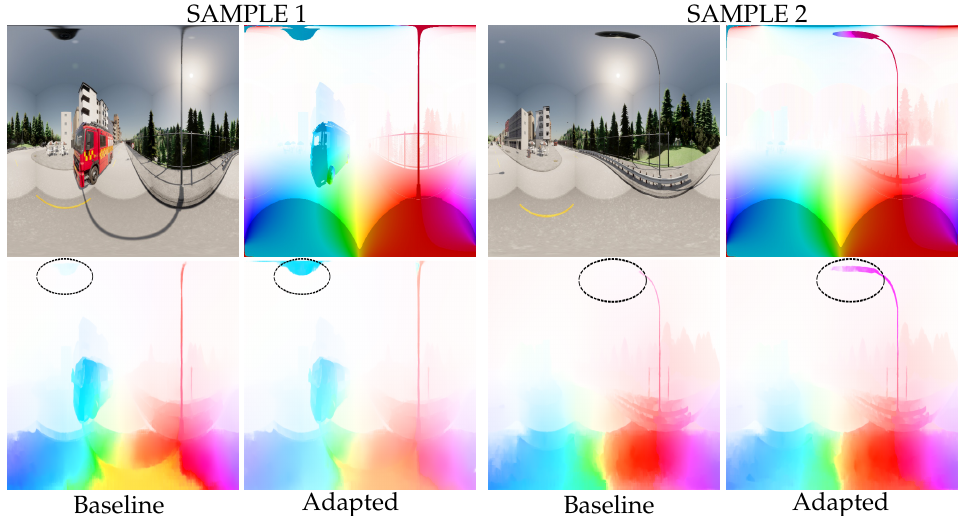
Figure 9. Prediction examples in the Flow360 dataset. Spherical adaptation allows better tracking of objects moving in polar regions. As a result, the estimation of the optical flow of the observed lamp post is significantly improved (area highlighted by the red circle). ( Top left ): RGB input, ( top right ): ground-truth optical flow, ( bottom left ): prediction from the baseline network, ( bottom right ): prediction from the adapted